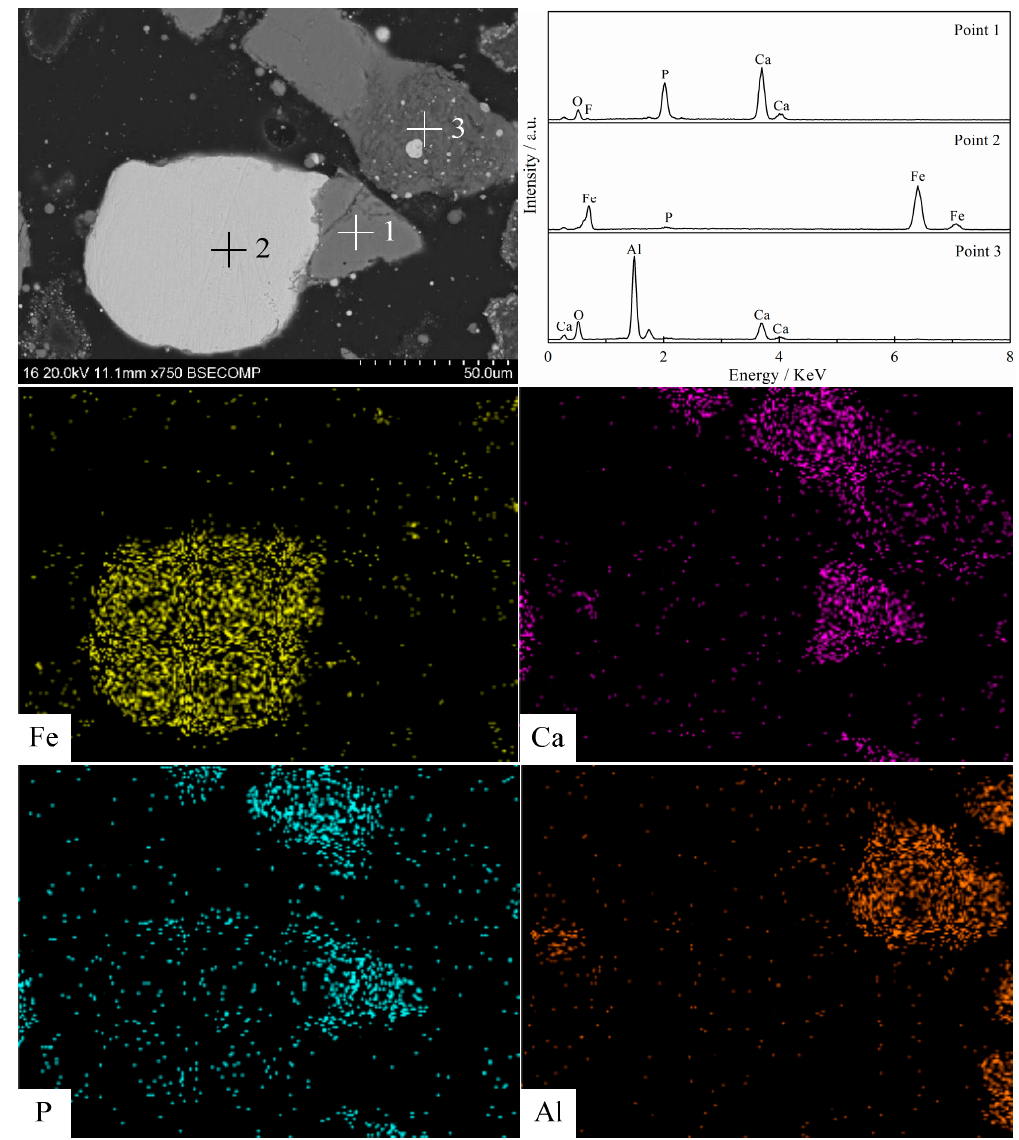
Figure 11. SEM image and energy dispersive spectrometer (EDS) spectra and line-by-line scanning analysis of the reduction product in the Ca 10 (PO 4 ) 6 F 2 –Al 2 O 3 –Fe 2 O 3 –C system (reduction temperature of 1473 K and reduction time of 60 min).